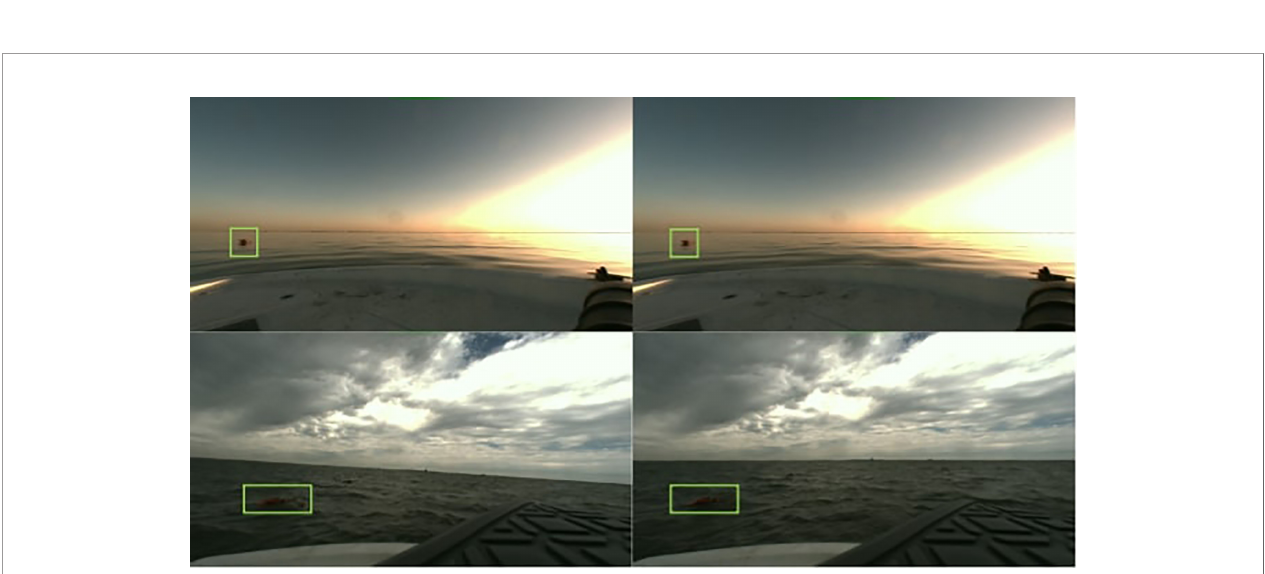
FIGURE 7 | Results of the object tracking algorithm where detection is done once and tracking is used to detect the object for the rest of the frames [Top left] Object detection module is used to detect the object of interest (Pelican). [Top Right]. Detected object is tracked in the next frame [Lower Left] The detection algorithm detects the object in the frame [Lower Right] tracking the object after 40.